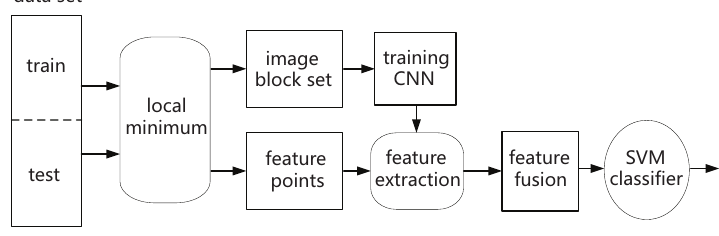
Figure 1. Flow chart of the methodology used in this